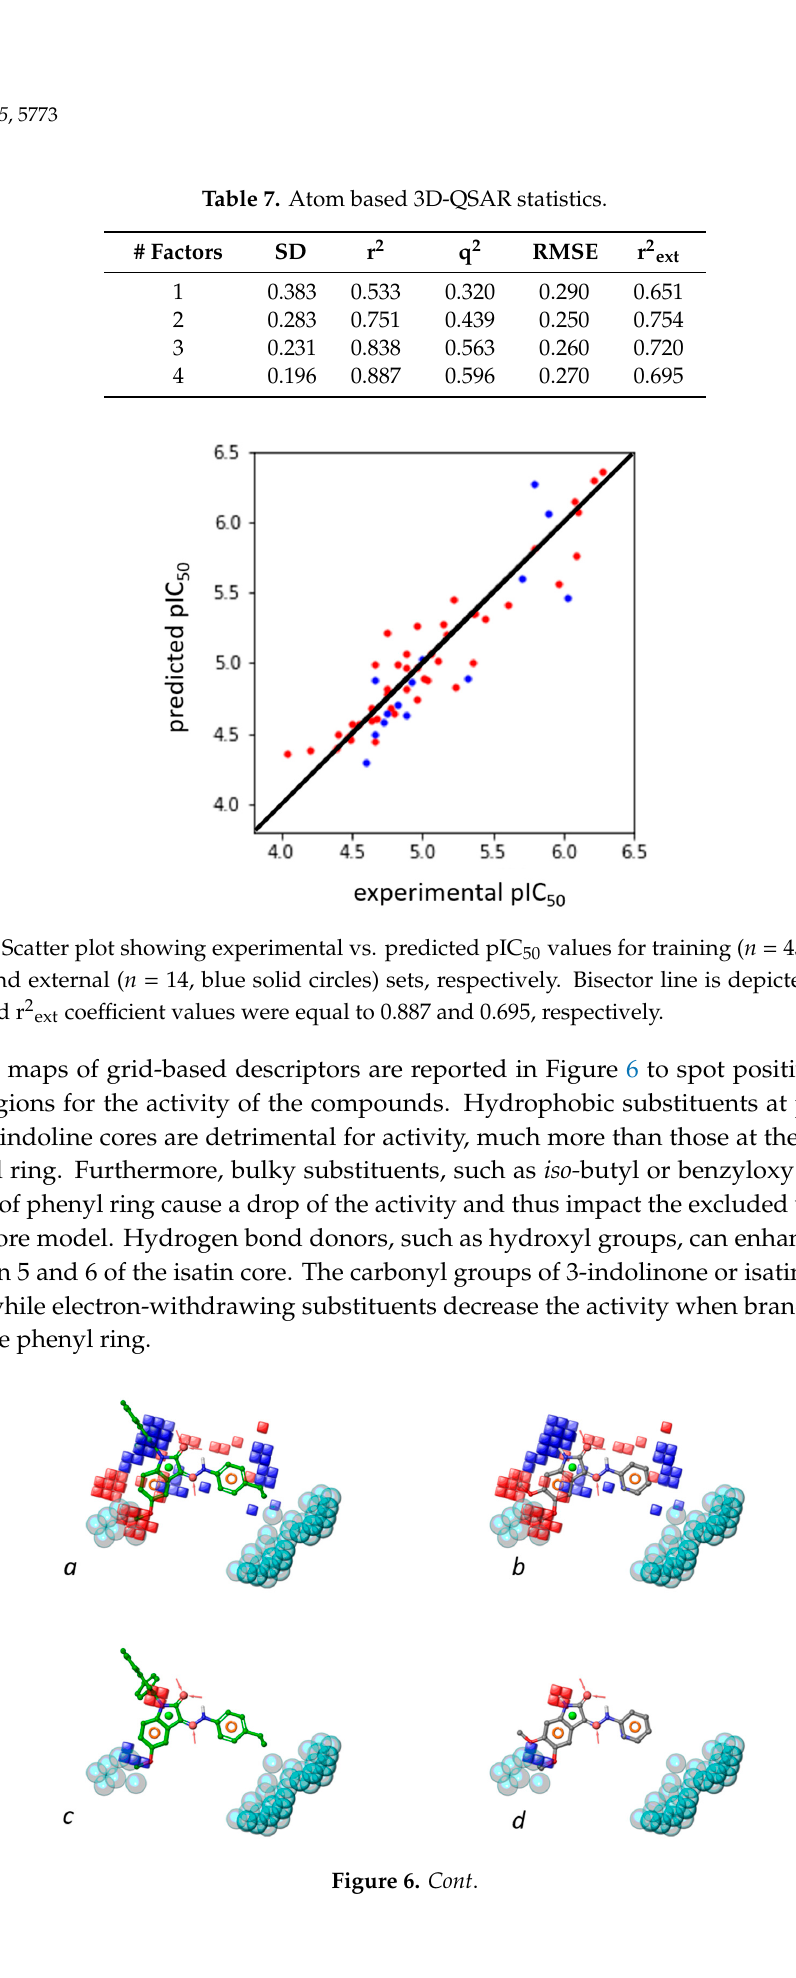
Figure 6. Contour maps rendered as blue and red cubes indicate positive and negative regions for activity. Specifically, panels ( a , c , e ) show the most active ligands within hydrophobic, HBD and electron withdrawing region, respectively; panels ( b , d , f ) show the most inactive ligands within hydrophobic, HBD and electron withdrawing regions, respectively. Pharmacophore features and excluded volumes are also reported. 3. Materials and Methods 3.1. General Information Commercial reagents and solvents were purchased from Sigma-Aldrich (Milan, Italy). Melting points (mp) were determined by the capillary method on a Stuart SMP3 electrothermal apparatus (Bibby Scientific, Milan, Italy). IR spectra were recorded using potassium bromide disks on a Spectrum One FT-IR spectrophotometer (Perkin Elmer, Milan, Italy); only the most significant IR absorption bands are reported. 1 H-NMR spectra were recorded in DMSO- d 6 , CDCl 3 or acetone- d 6 on a Mercury 300 or 500 spectrometer (Varian, Cernusco s. N., Italy). Chemical shifts are expressed in δ (ppm) and the coupling constants J in Hz. The following abbreviations were used: s, singlet; d, doublet; t, triplet; qn, quintuplet; ep, eptuplet; dd, double doublet; td, triplet of doublets; m, multiplet; br s, broad singlet. Chromatographic separations were performed on silica gel 63–200 (Merck, Milan, Italy). ESI-MS was performed with an electrospray interface and an ion trap mass spectrometer (1100 Series LC/MSD Trap System, Agilent, Palo Alto, CA, USA). The sample was infused via a KD Scientific syringe pump at a rate of 10 mL/min. The pressure of the nebulizer gas was 15 psi. The drying gas was heated to 350 °C at a flow of 5 L/min. Full-scan mass spectra were recorded in the mass/charge ( m / z ) range of 50–800 amu. For some representative compounds, HRMS experiments were performed with a dual electrospray interface (ESI) and a quadrupole time-of-flight mass spectrometer (Q-TOF, Agilent 6530 Series Accurate-Mass Quadrupole Time-of-Flight LC/MS, Agilent Technologies Italia S.p.A., Cernusco sul Naviglio, Italy). Compounds 2 [42], 4 [43] , 5 [44], 10 – 12 and 14 [19], 30 [45], 33 [15], 44 [23] and 45 [24] have been prepared according to quoted references and their analytical data agreed with those reported in the literature.